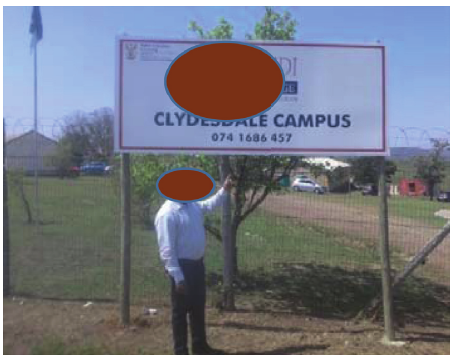
Figure 12: TVET college: site three.